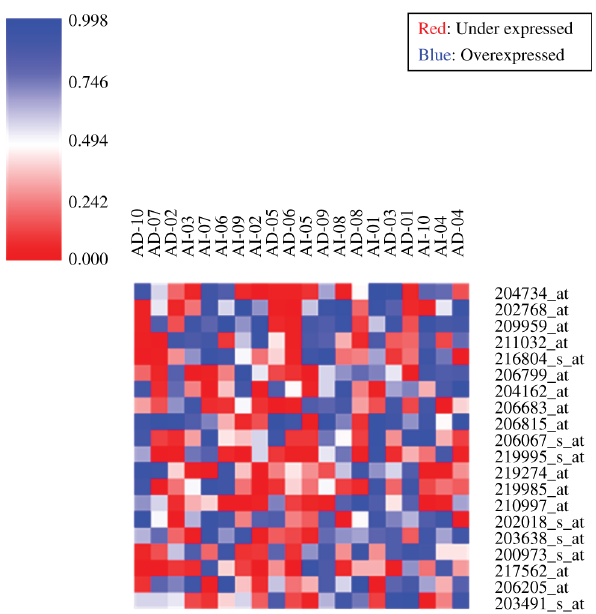
Figure 5: GeneSD analysis for GSE2443 (20 samples), representative heatmap with red color showing under expressed probes and the blue ones being overexpressed.